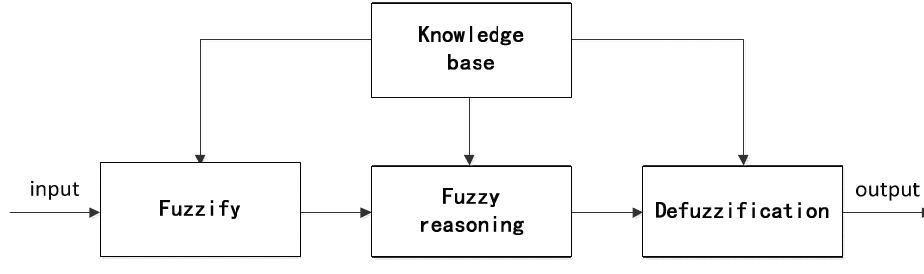
Figure 2. The basic principle of the fuzzy